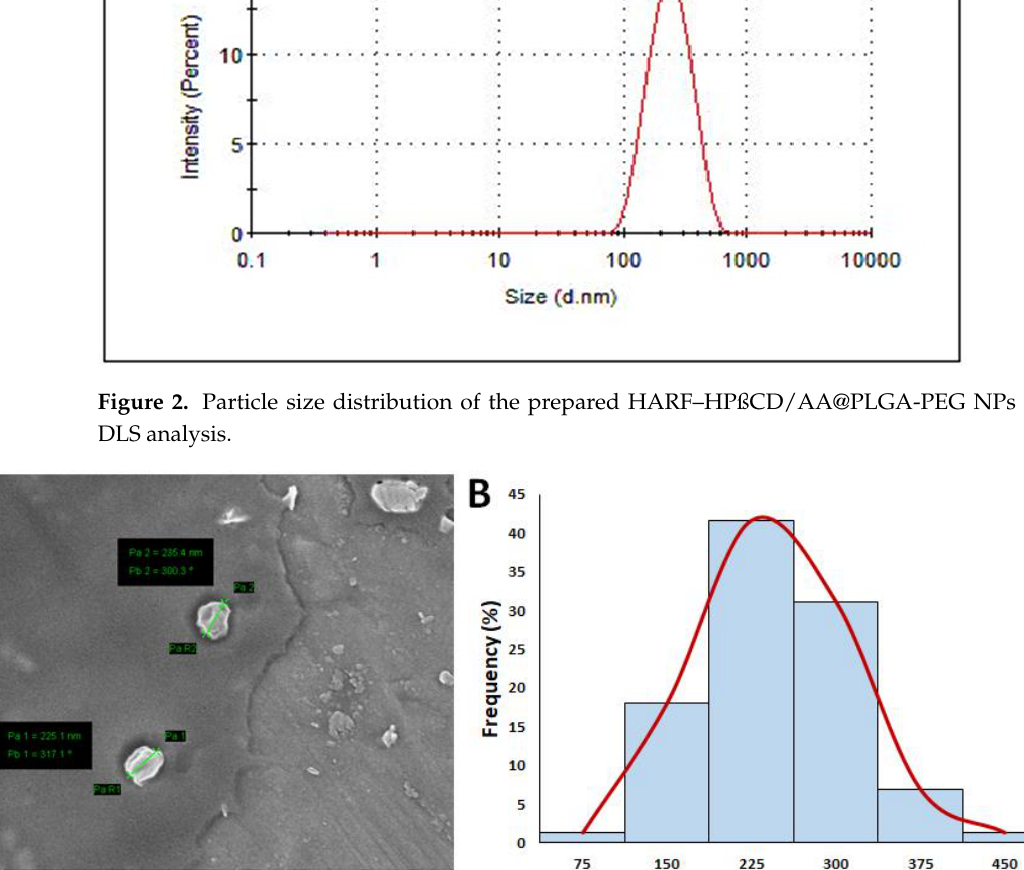
Figure 2. Particle size distribution of the prepared HARF – HPßCD/AA@PLGA-PEG NPs using DLS